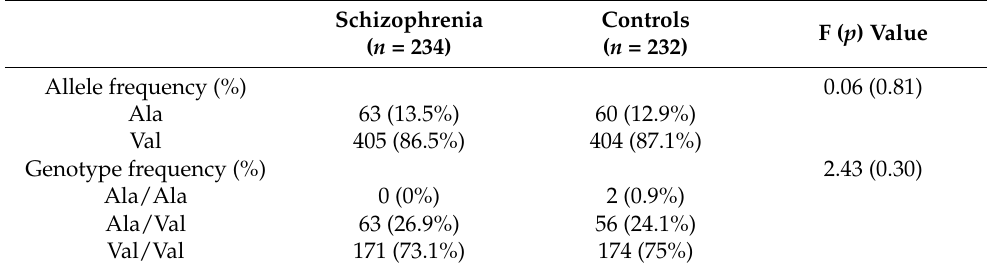
Table 2. MnSOD allele and genotype distributions in patients with schizophrenia and healthy controls.